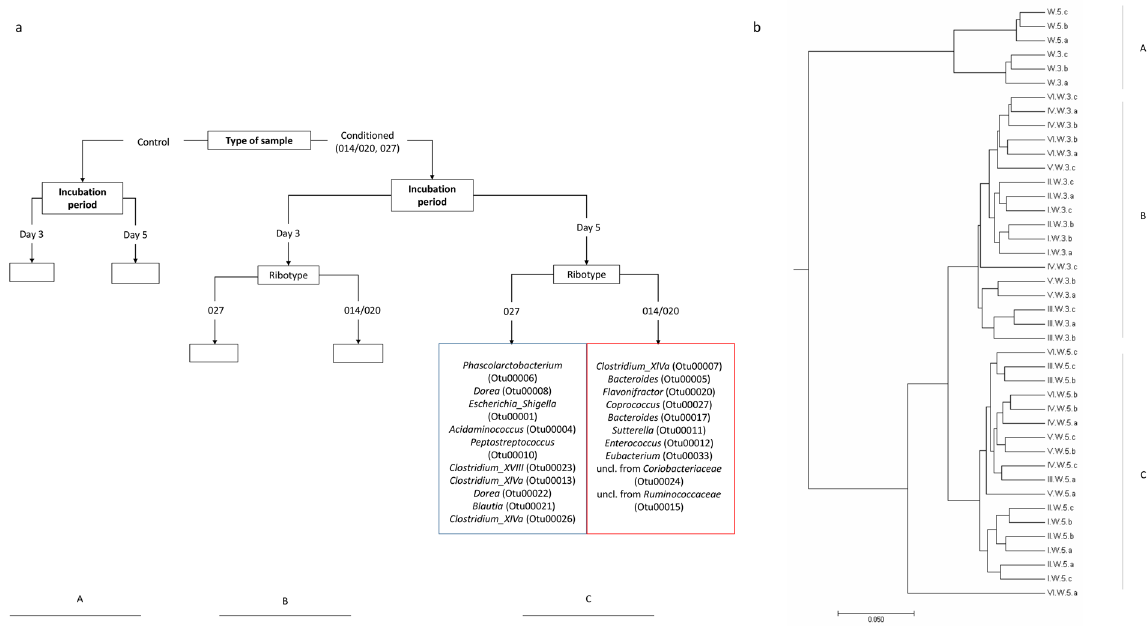
Figure 2. Clustering of samples according to ( a ) machine learning (PCT, CLUS software) and ( b ) mothur analysis (tree viewed by MEGA software, v.7.0.26). Samples clustered in three groups, i.e. group of WCAB (Wilkins Chalgren Anaerobe Broth) control medium samples (segment A), group of WCAB conditioned medium samples after three days of incubation (segment B) and group of WCAB conditioned medium samples after five days of incubation (segment C). A predictive clustering tree (PCT) predicts the OTU composition of a sample from the environmental conditions and the ribotype. The leaves of the tree, corresponding to clusters of samples with similar OTU composition, predict the relative abundances of the OTUs, while the path to each leaf from the root of the tree explains the cluster in terms of the environmental conditions. During PCT construction, tests for the internal nodes of the tree are chosen to maximize the similarity in OTU composition for the samples that go to the same branch and maximize the differences between the samples that go to the left and the right branch, respectively (segments A, B, C). The segment C shows the difference in OTU composition between the fifth and the sixth leaf node from the left. The fifth node represents OTUs associated with ribotype 027 (blue box), the sixth node represents OTUs associated with ribotype 014/020 (red box), after five day incubation period in WCAB growth medium. The differences in values of relative abundances between the two ribotypes for OTUs are presented in Fig.